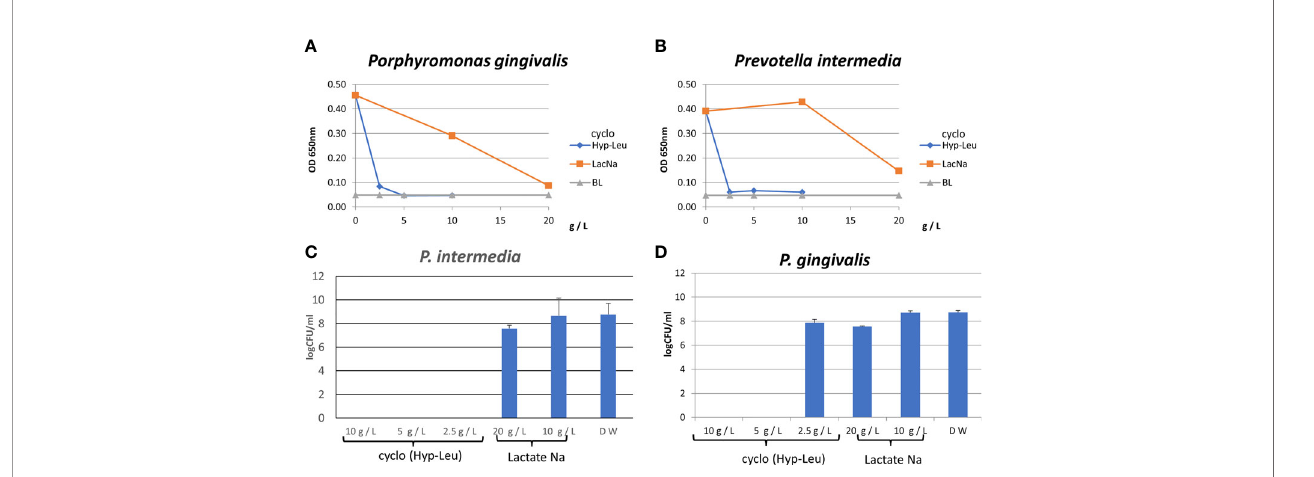
FIGURE 6 | Antibacterial activity of synthesized cyclo (Hyp-Leu). (A, B) Show the results of the turbidity assay. BL is medium only. (C, D) Show the result of the CFU